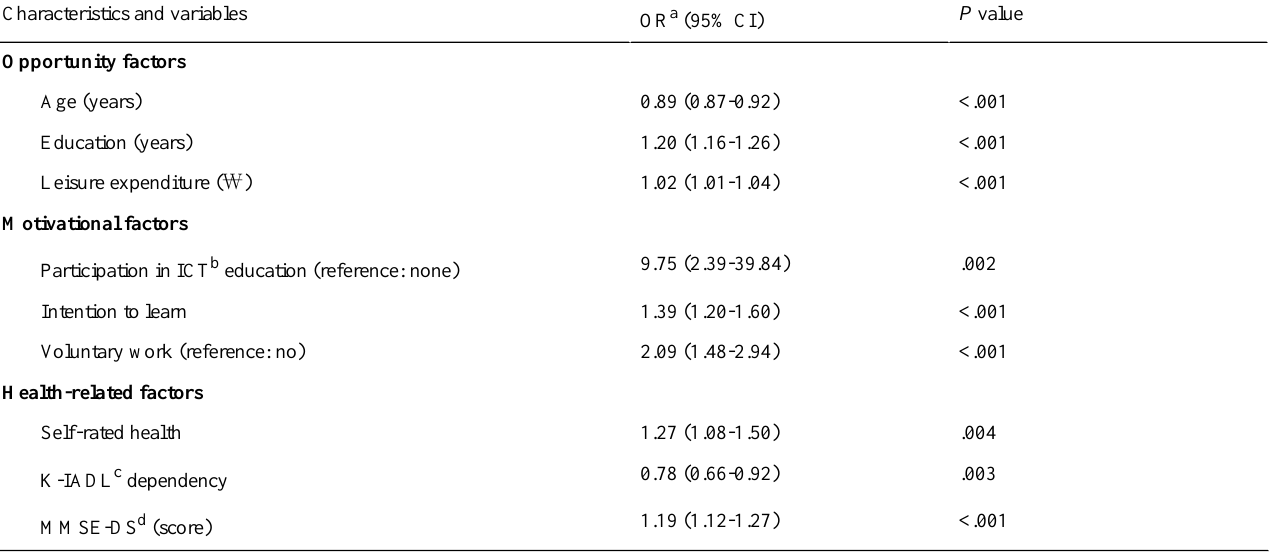
Table 2. Logistic regression model predicting internet use among older adults with diabetes mellitus